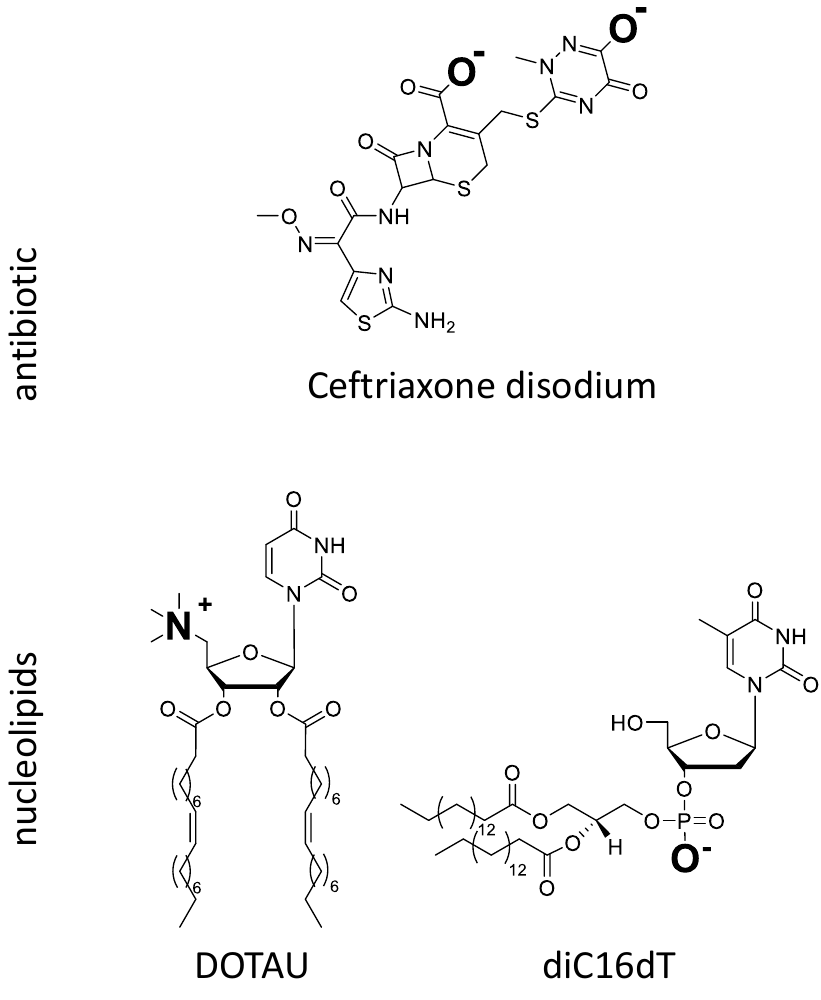
Figure 1. Chemical structure of CFX and nucleolipids (DOTAU and diC16dT) ionized in aqueous medium at neutral